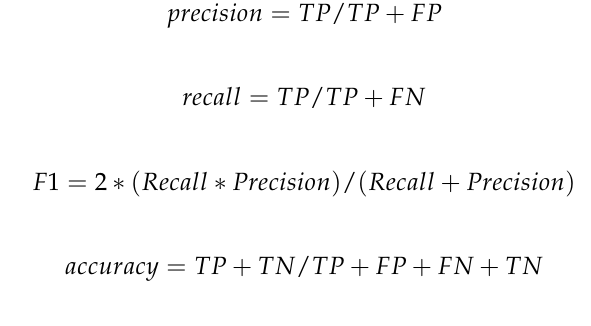
Table 4. Precision, recall, and F1-Score metrics for the two